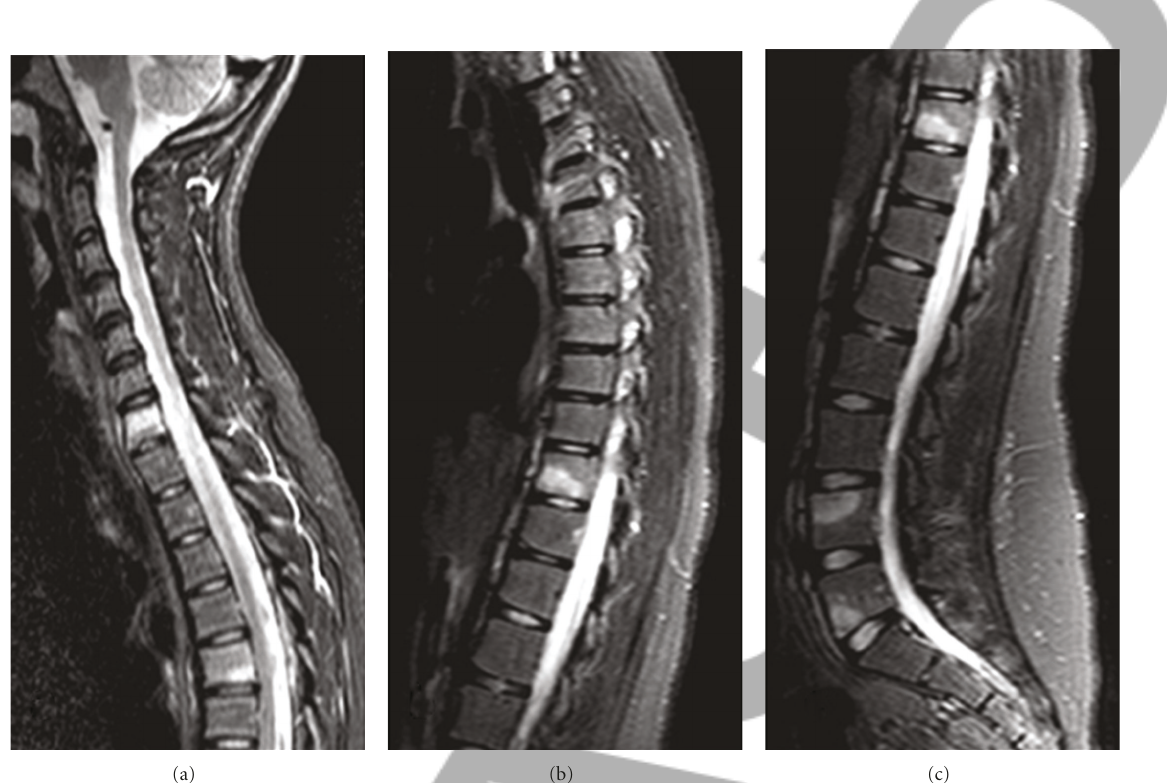
Figure 1: MRI of the spine at the disease presentation. Multiple vertebrae lesions are demonstrated in the cervical, thoracic, and lumbar spine, which exhibit increased signal intensity on sagittal T2-weighted images (a), (b), and (c). The appearance of the intervertebral discs is normal.